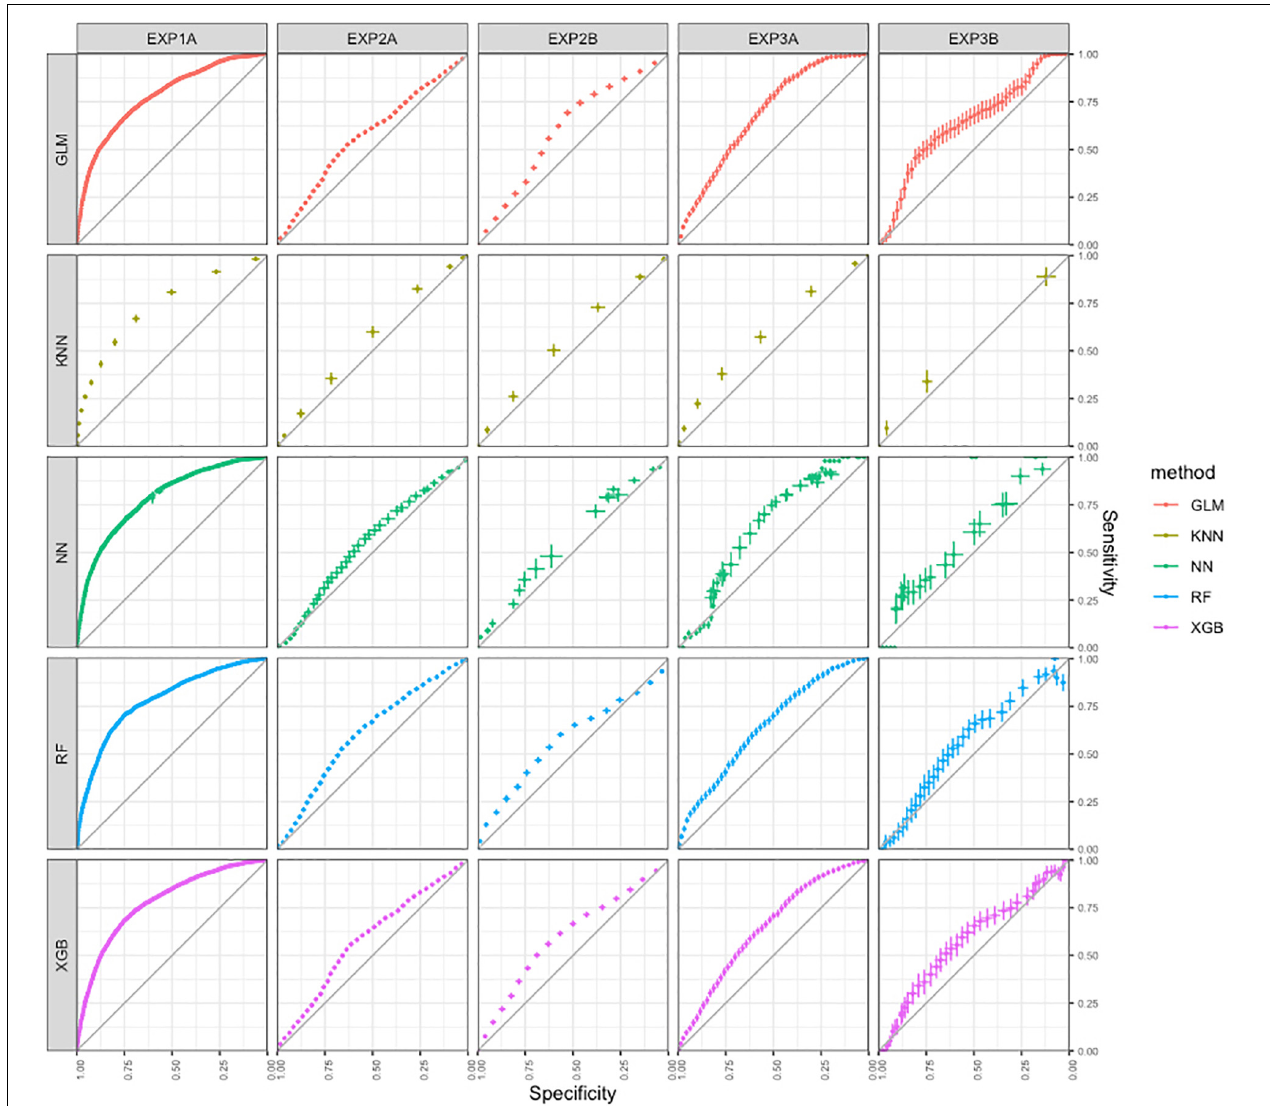
FIGURE 2 | ROC-curves for the predictive ability of the models in all three studies built with five machine learning